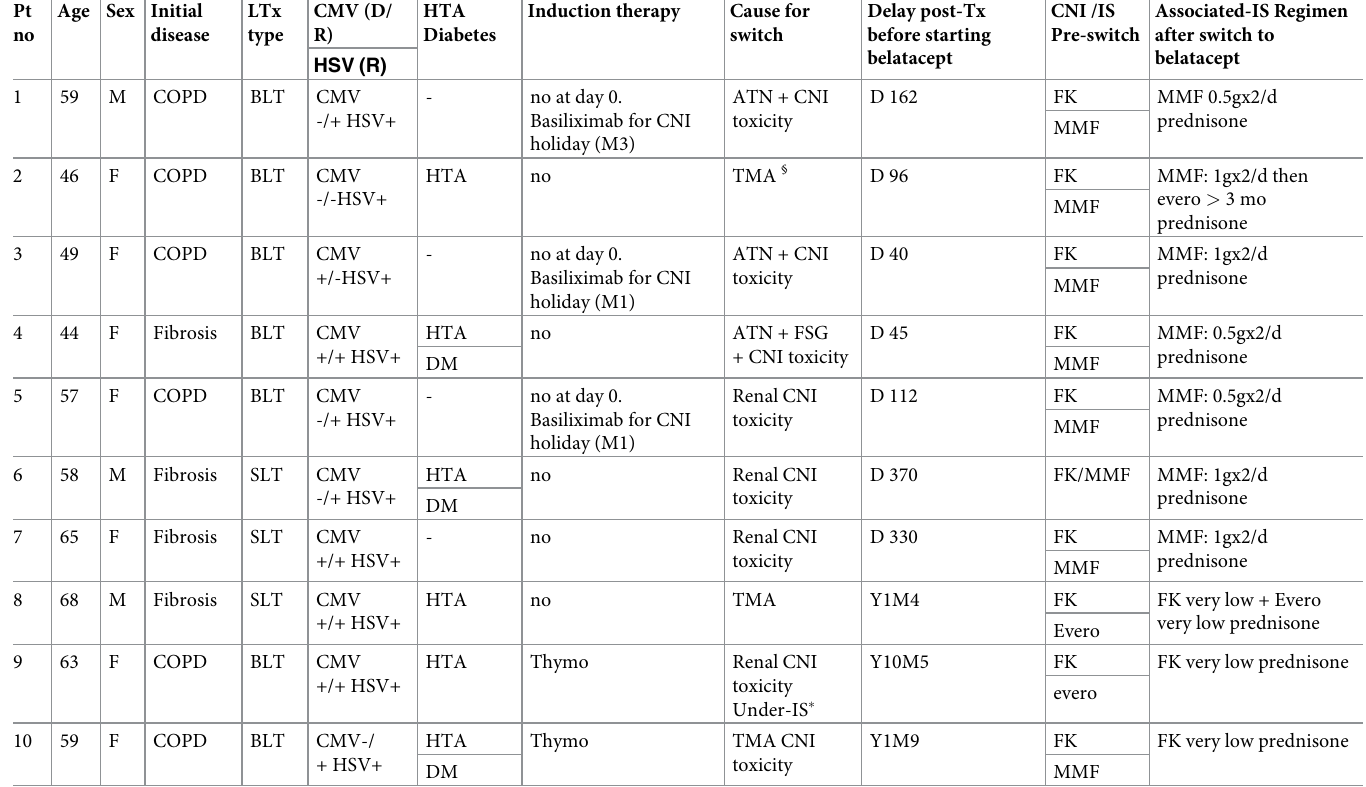
Table 1. Characteristics of patients.